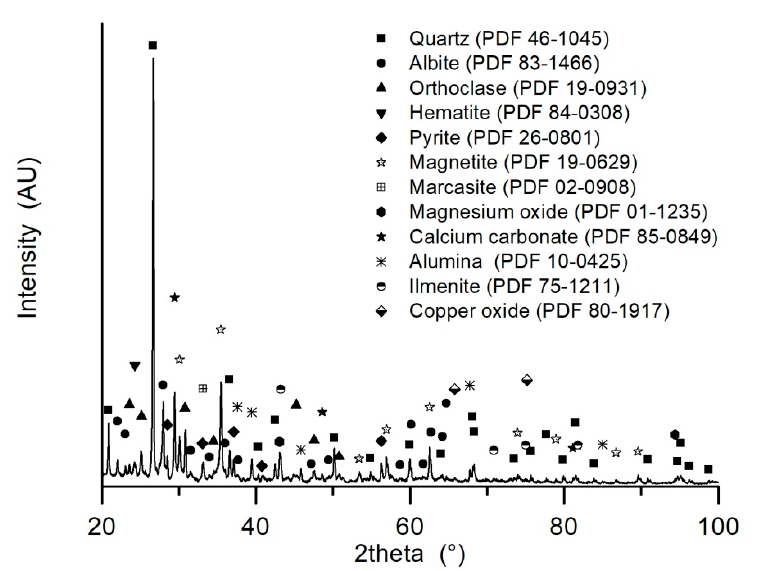
Figure 4. XRD patterns for industrial copper tailings particles.